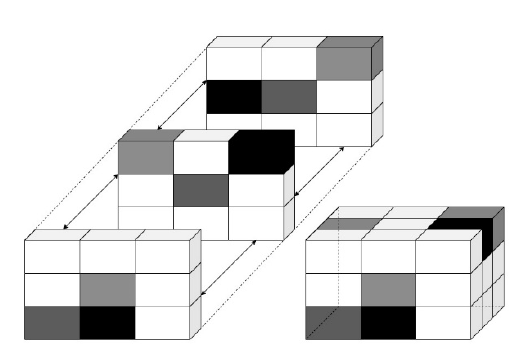
Figure 5. Representation of Volumetric Structure in 3D with grey intensities.